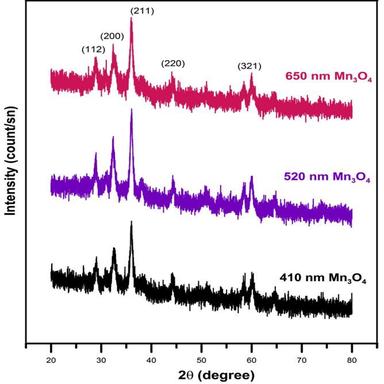
X-ray diffraction patterns of the Mn3O4 films deposited by SILAR technique on the soda-lime-silica glass substrate with thicknesses of 410 nm, 520 nm, and 650 nm. Peak locations at the XRD for each film indicates Mn3O4 films were successfully produced.